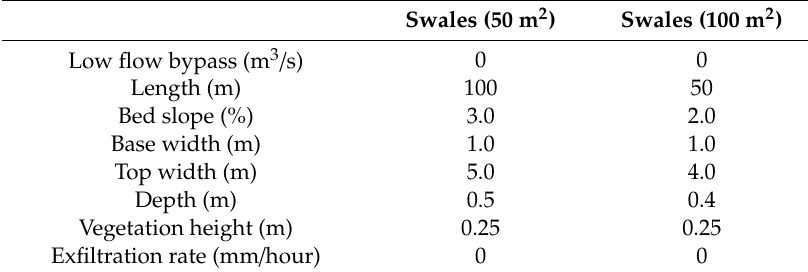
Table A4. Parameters of two types of swales in MUSIC.